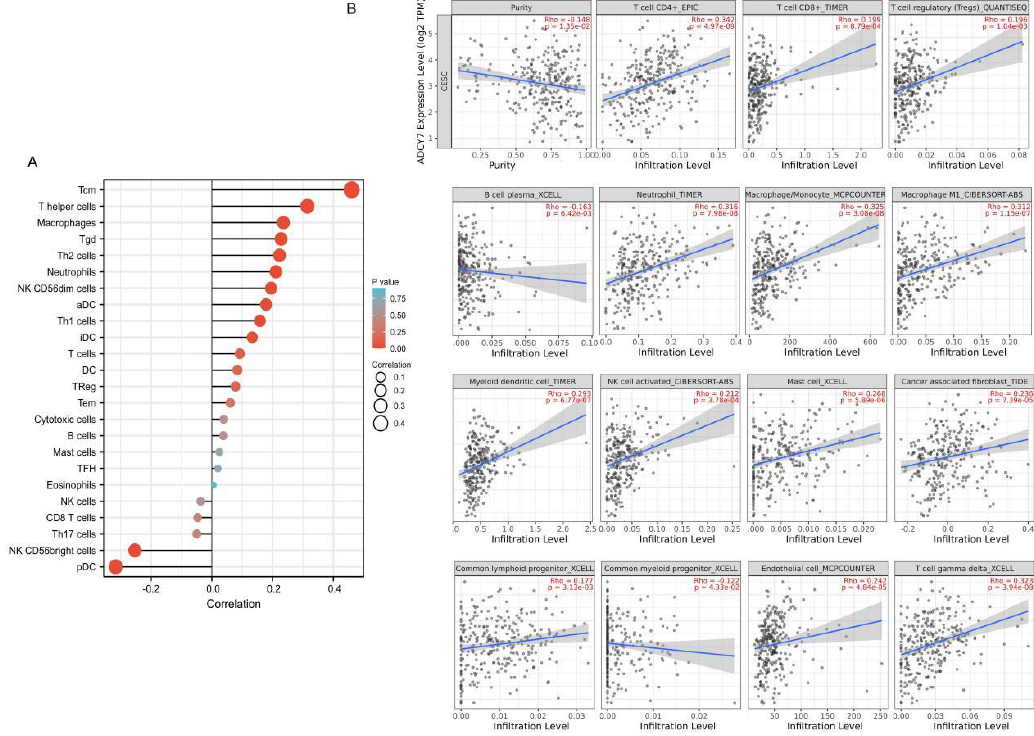
Figure 5. Correlation of ADCY7 expression with immune infiltration in cervical cancer . ( A ) Correlation between the expression of ADCY7 and the abundance of TILs in cervical cancer. ( B ) Correlation between ADCY7 expression and infiltration levels of CD4+ T cells, T cells gamma delta, macrophages, neutrophils, M1 macrophages, myeloid dendritic cells, mast cells, endothelial cells, cancer-association fibroblasts, and NK cells in cervical cancer available in the TIMER2.0 database. TILs, tumor-infiltrating lymphocytes; TIMER2.0, Tumor Immune Estimation Resource. Color images are available online.